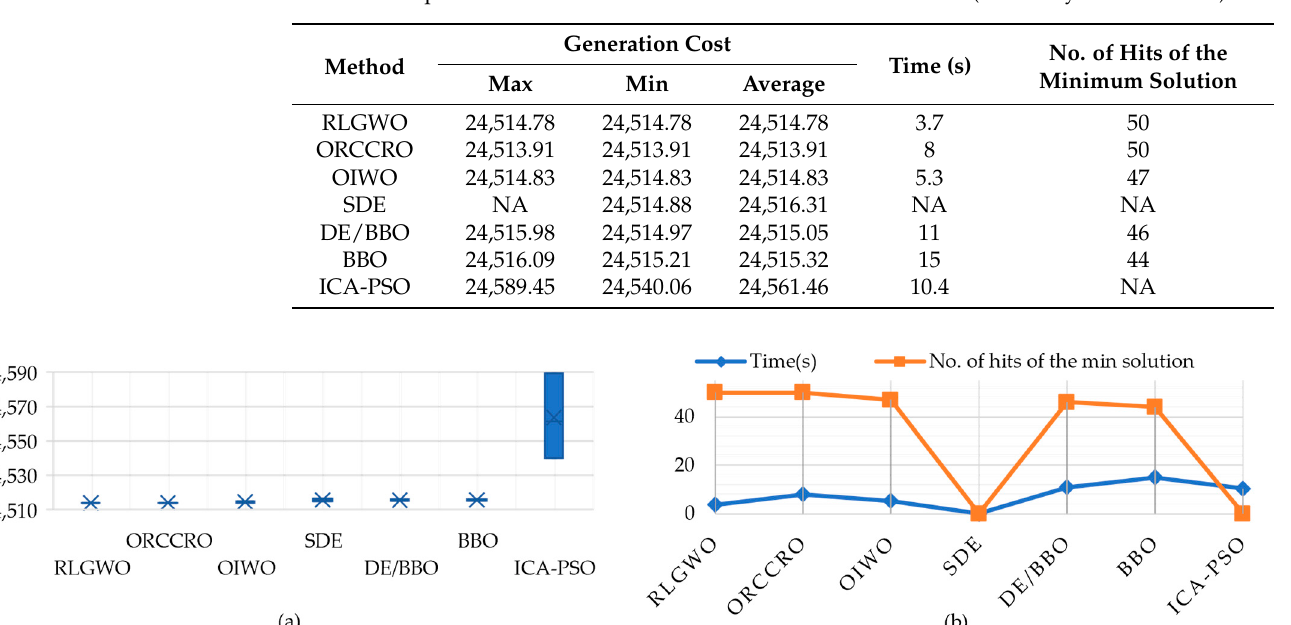
Figure 4. Comparative convergence characteristic of original GWO and proposed RLGWO algorithm for the 13-unit system. Table 2. Comparison between different methods taken after 50 trials (13-unit system with loss).